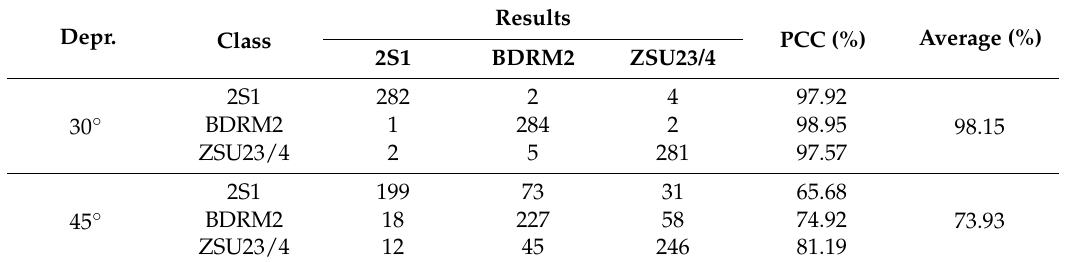
Figure 10. Noisy images with different levels of additive white Gaussian noises (AWGN) addition.